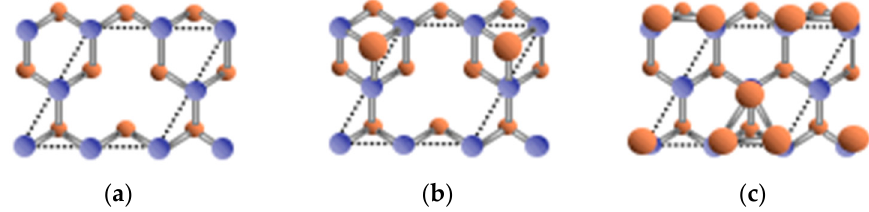
Figure 1. Schematics of top view of InAs(111)A-(2 × 2) with ( a ) In-vacancy; ( b ) As-adatom; and ( c ) As-trimer surfaces considered in this study. Blue and orange atoms denote In and As, respectively.